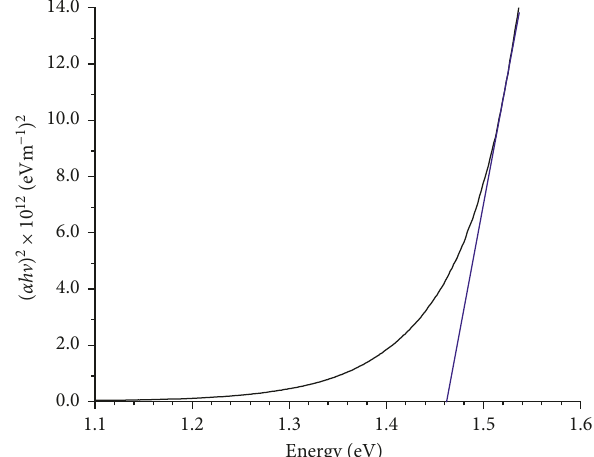
Figure 9: ( αh ] ) 2 versus h ] spectra for the calculation of direct band gap of CZTS assembly synthetized with 0.324 g of PVP and de- posited by thermal